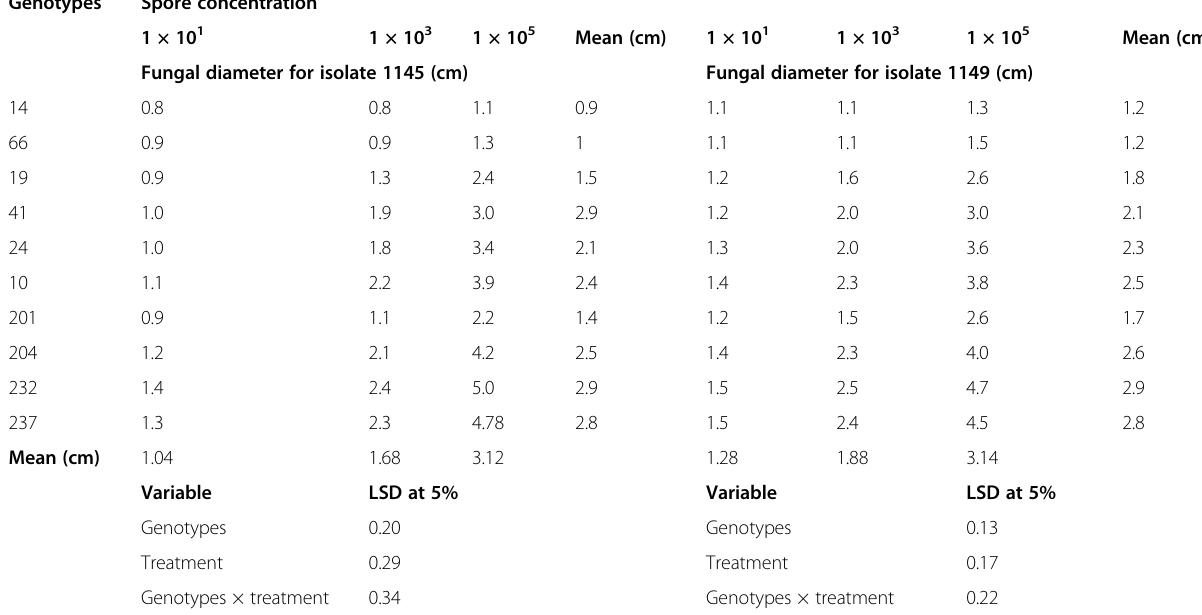
Table 2 Effect of conidial concentration of Fsd (1145 and 1149) on callus of D. sissoo genotypes